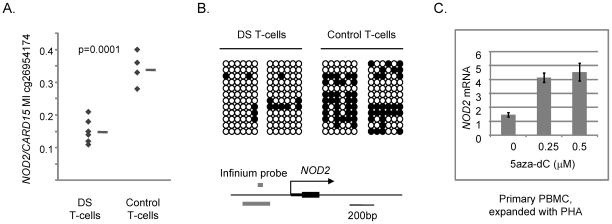
Differential DNA methylation in the CARD15/NOD2 gene in DS versus normal T-cells and induction of NOD2 mRNA by 5aza-dC.A, Fractional methylation values from the Infinium assays showing differential methylation at cg26954174 in the NOD2 promoter region in DS versus control T-cells. B, Bisulfite sequencing showing relative hypomethylation in the (non-CGI) promoter region of NOD2 in DS T-cells. The map of the NOD2 promoter region shows the location of the Infinium probe (grey bar above the line, cg26954174); the region subjected to bisulfite sequencing is shown by the grey bar below the line. C, Increased expression of NOD2 mRNA in PBMCs exposed to 5aza-dC at the indicated concentrations for 3 days. The short term cultures of PBMCs were grown in the presence of PHA to induce a polyclonal proliferation of T-cells.